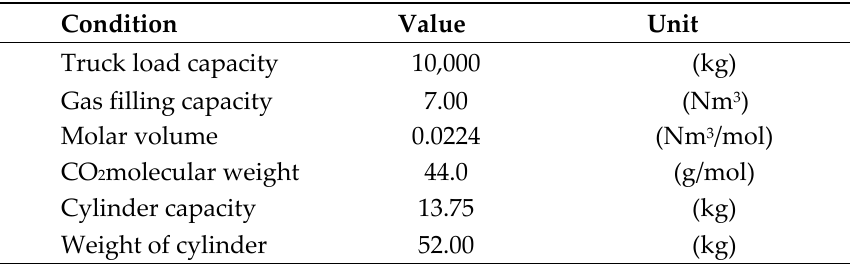
Table 4. Calculation condition of CO 2 load capacity by gas bomb truck.